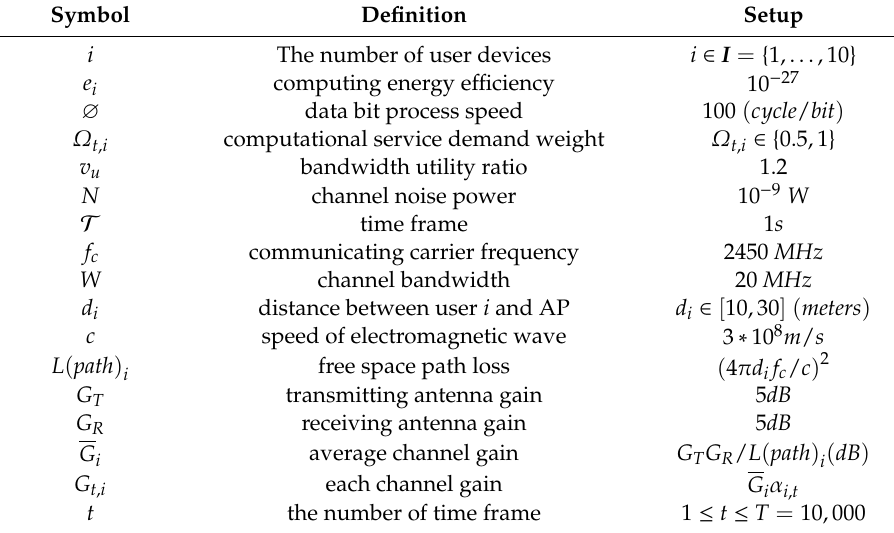
Table 2. The related symbols in our